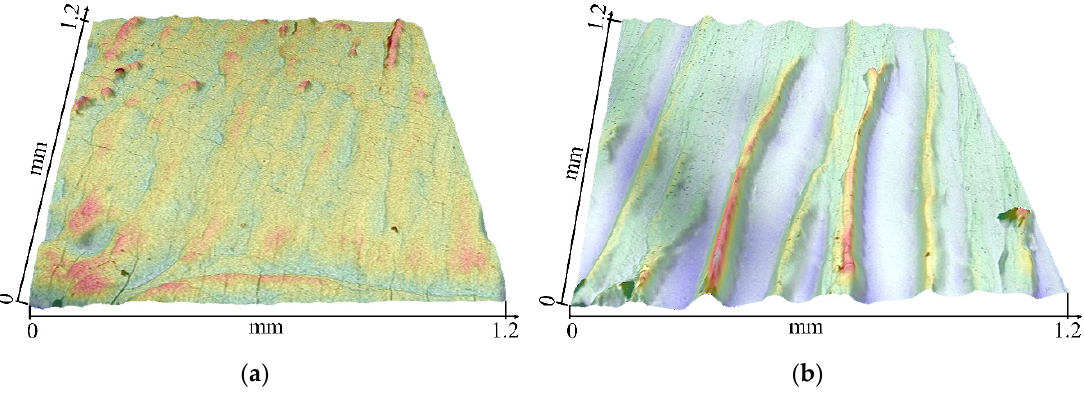
Figure 8. Topography of the cut surfaces obtained with run ( a ) No. 1 (150 W, 150 cm/min, 2 bar) and ( b ) No. 7 (300 W, 150 cm/min, 4 bar).